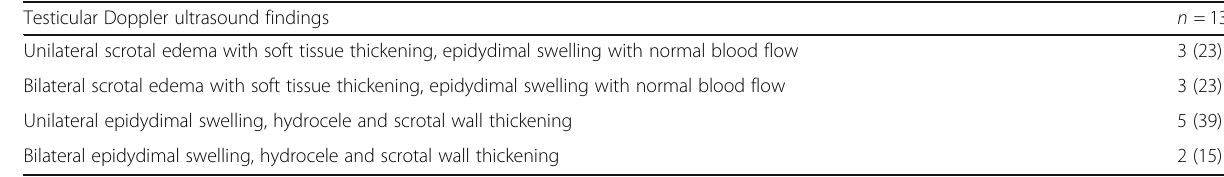
Table 1 Testicular Doppler ultrasound findings in 13 IgA vasculitis patients Testicular Doppler ultrasound